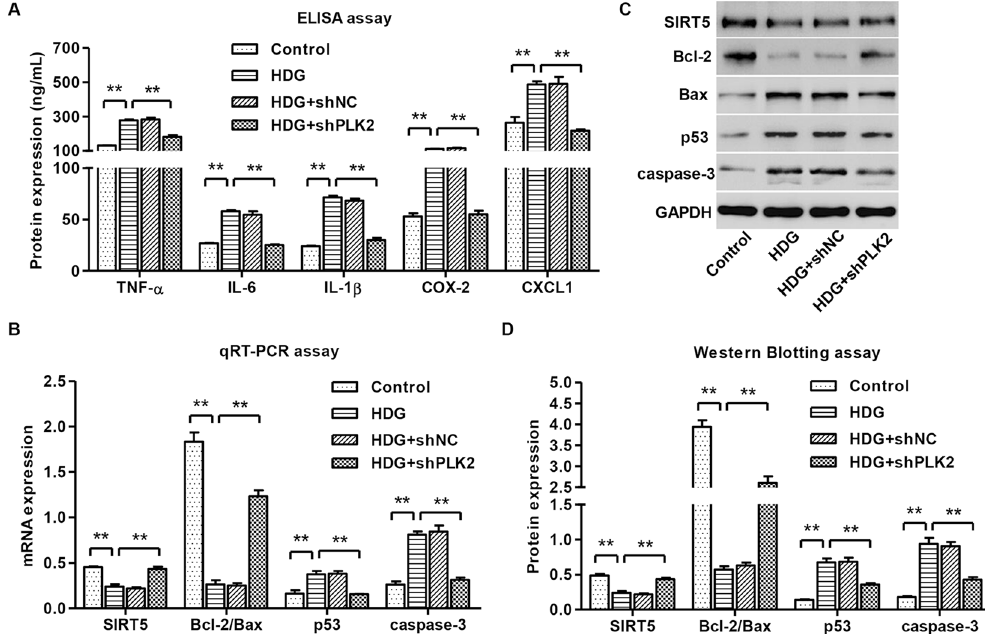
Figure 5. Knocking down PLK2 inhibited inflammatory responses and decreased apoptosis-associated markers. Mouse podocytes were treated with 30 mM HDG for 12 h or 24 h. ( A ) TNF- α , IL-6, IL-1 β , COX-2 and CXCL1 were measured by ELISA assay. Apoptosis-associated markers SIRT5, Bcl-2/Bax, p53 and cleaved caspase-3 were measured by real-time PCR ( B ) and western blot analysis ( C,D ). HDG effects were reversed in shPLK2 group. ** P <